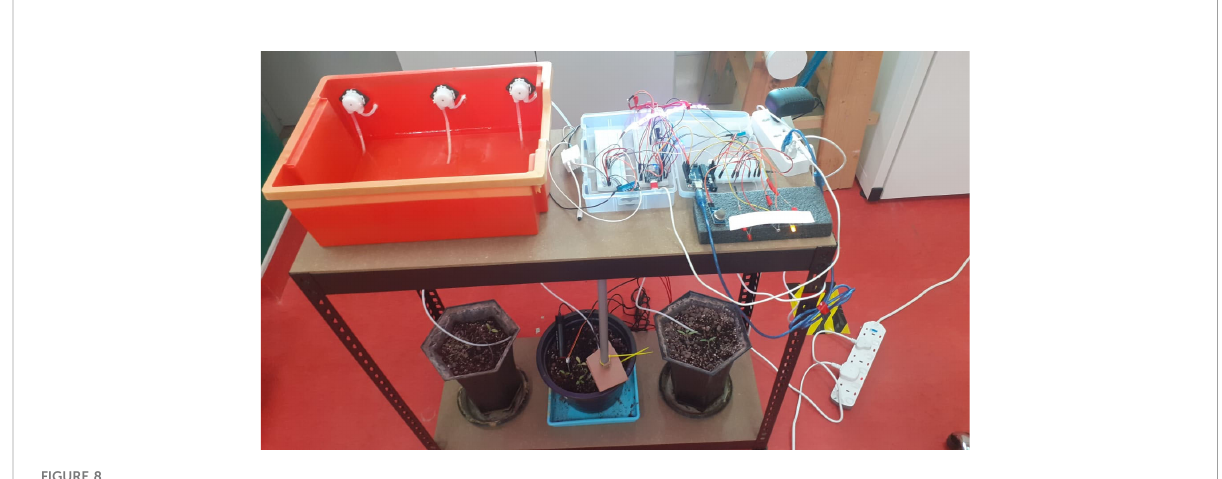
FIGURE 8 The physical design of the